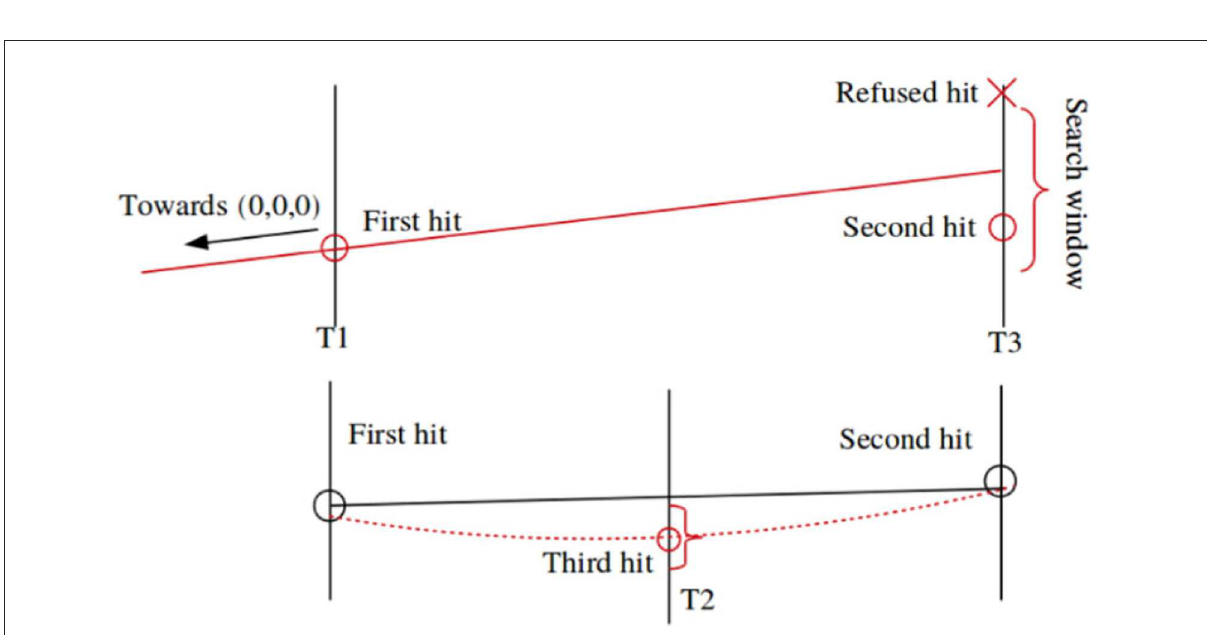
FIGURE6 Formation of the triplets in x-z search. The position of a hit in a first layer is projected onto a second layer assuming infinite momentum, and all hits around that projection, given a momentum-dependent tolerance, are used to form 2-hit combination. A third hit is then looked for in a third layer using the estimated momentum from the 2-hits